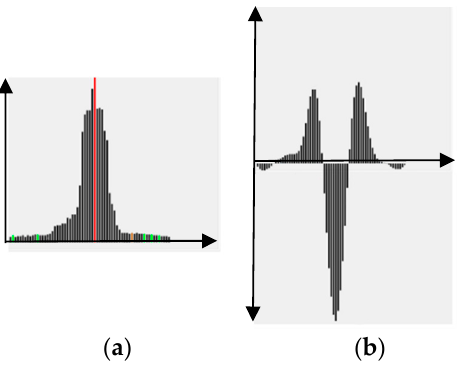
Figure 5. The curves of ( a ) 𝐹𝑃 𝑠 and ( b ) its second derivative.